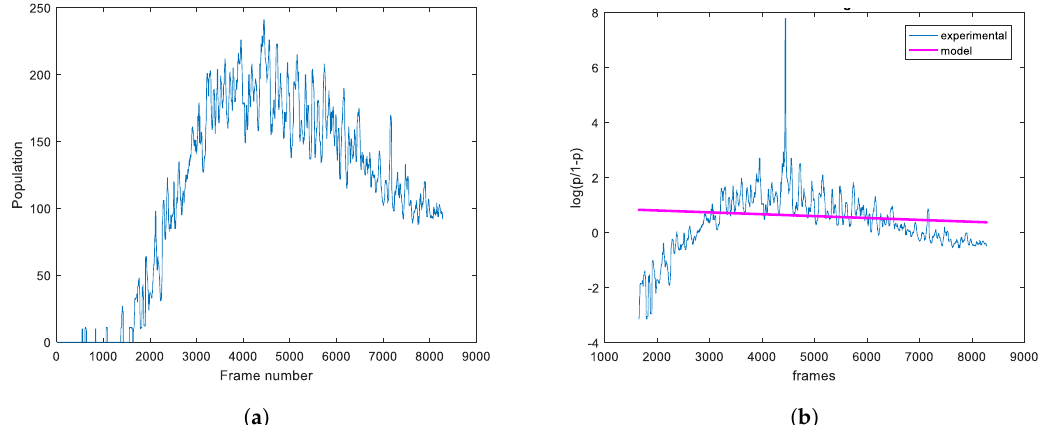
Figure 10. ( a ) An example of a population curve with negative b 1 of the LF. ( b ) The logarithmic quotient and its classic LF